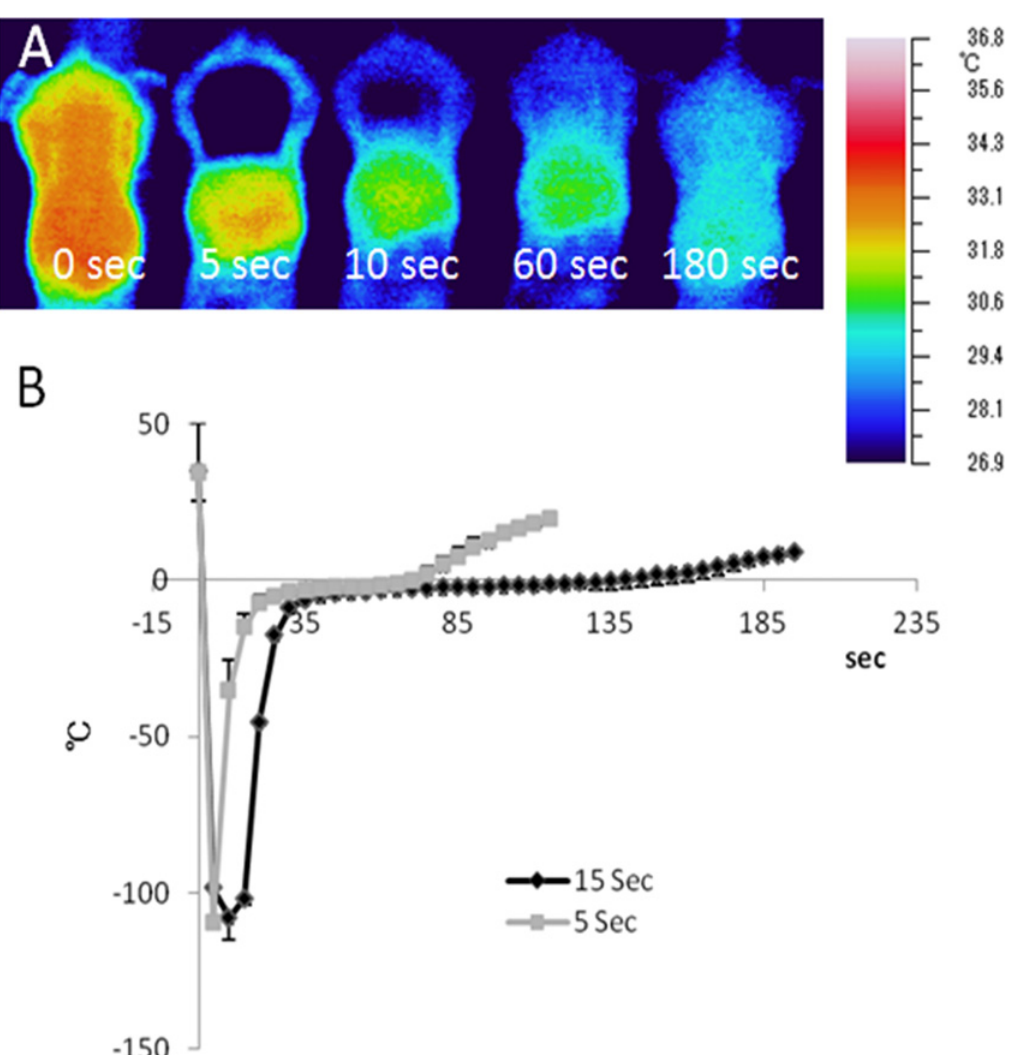
Fig 3. Changes of temparature of tissues after cryoablation. A) The temperature change of skin surface after 5-sec or 15-sec cryoablation was monitored by thermography. The thermometer probe was inserted into the subcutaneous tissue. B) The temparature recovered more slowly in the 15-sec than in the 5-sec cryoablated group. The increase of temparature became blant just bellow 0°C, where recrystallization and the following tissue damage occur. sec; seconds. All values represent the mean ± SEM. n = 4, in each